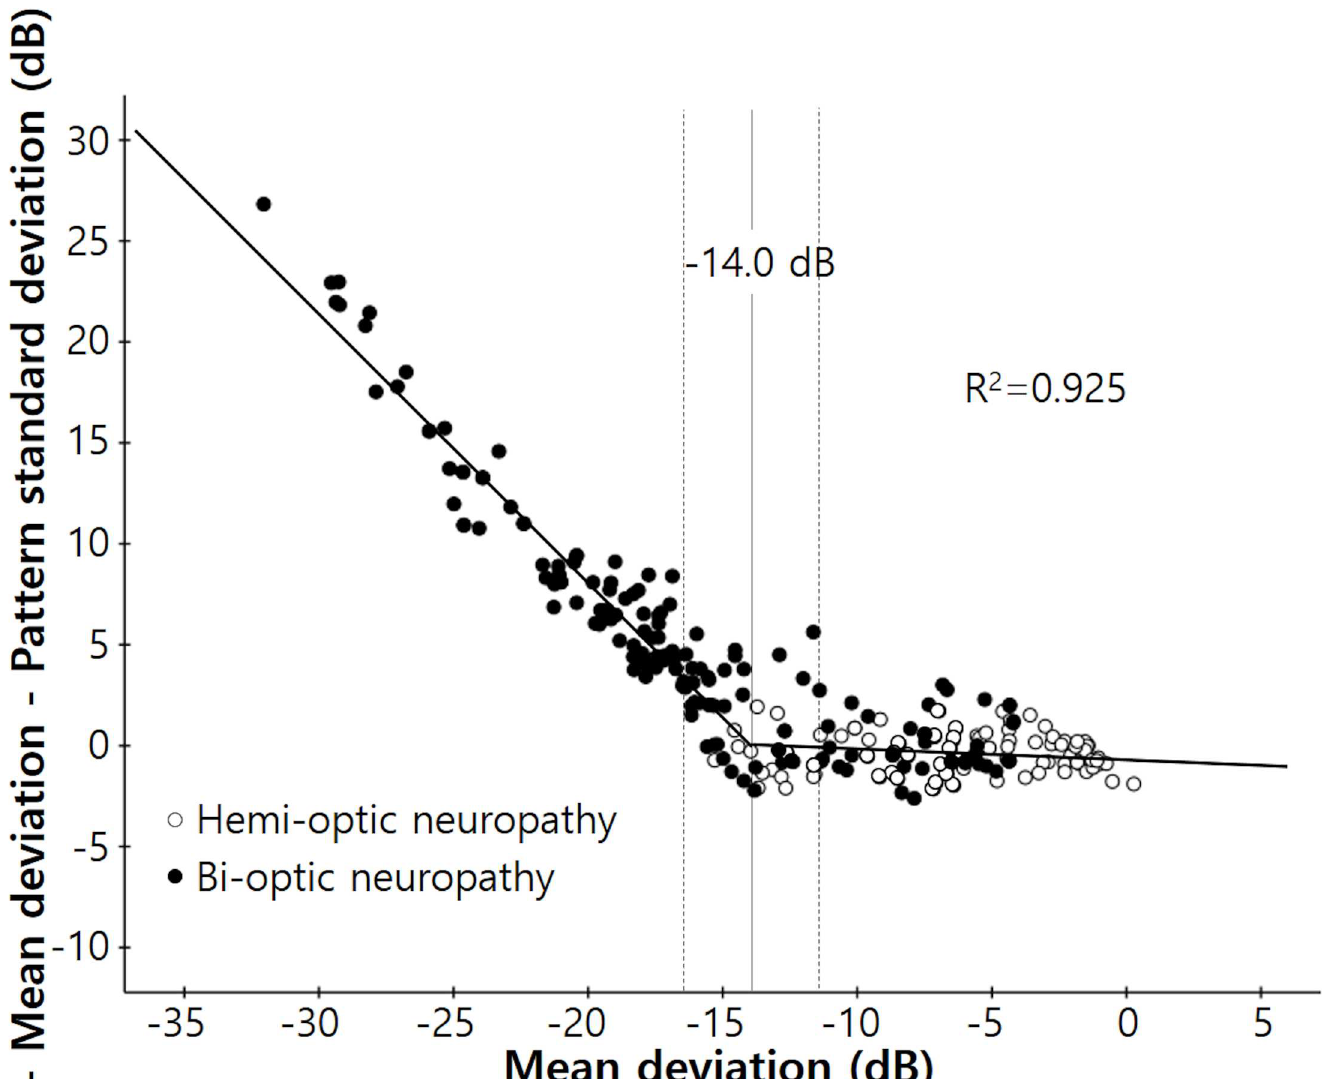
Fig 5. Scatterplot of the differences between negative MD and PSD values with regard to the MDs of the enrolled patients. The “broken stick” model is designatedby the black line. The tipping point was − 14.0 dB (95% confidenceinterval, − 16.2 ~ − 11.8 dB, P < 0.001); the slope belowthe tipping point was given by Y = − 18.469 − 1.328X and the slope above the tippingpoint was given by Y = − 0.445 − 0.043X ( P <